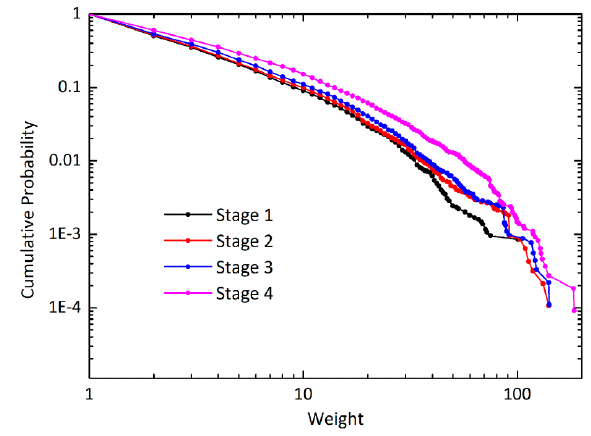
Figure 6. Cumulative probability of weight distribution.